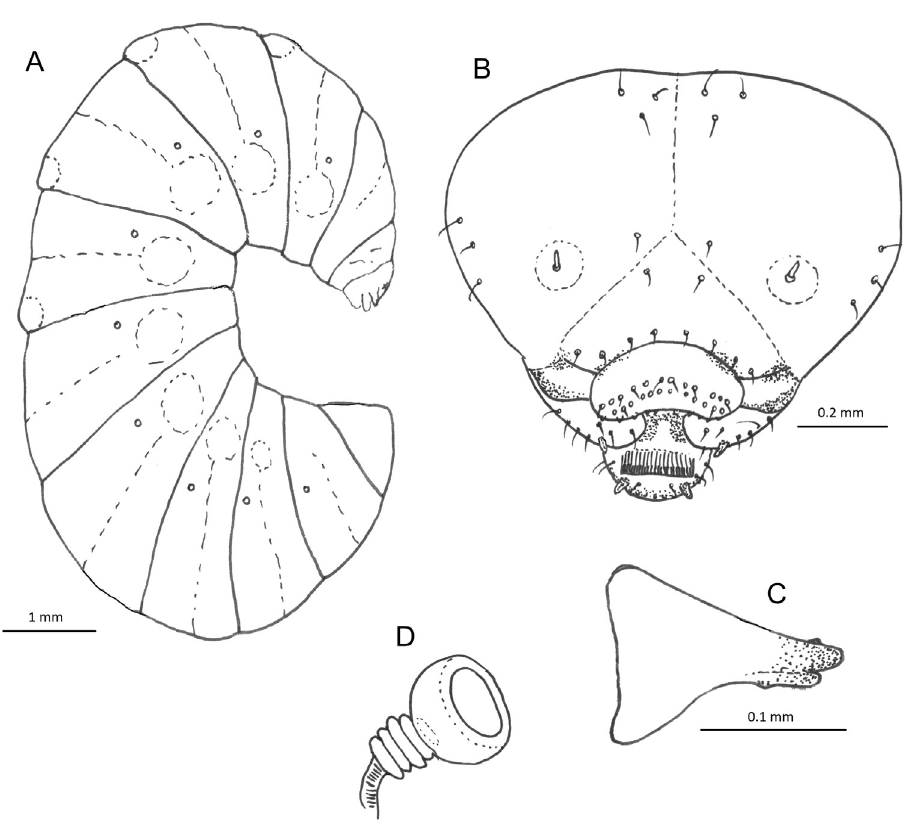
Figure 4. Mature larva of Pseudoanthidium tenellum A lateral view B head, frontal view C mandible, lateral view, and D